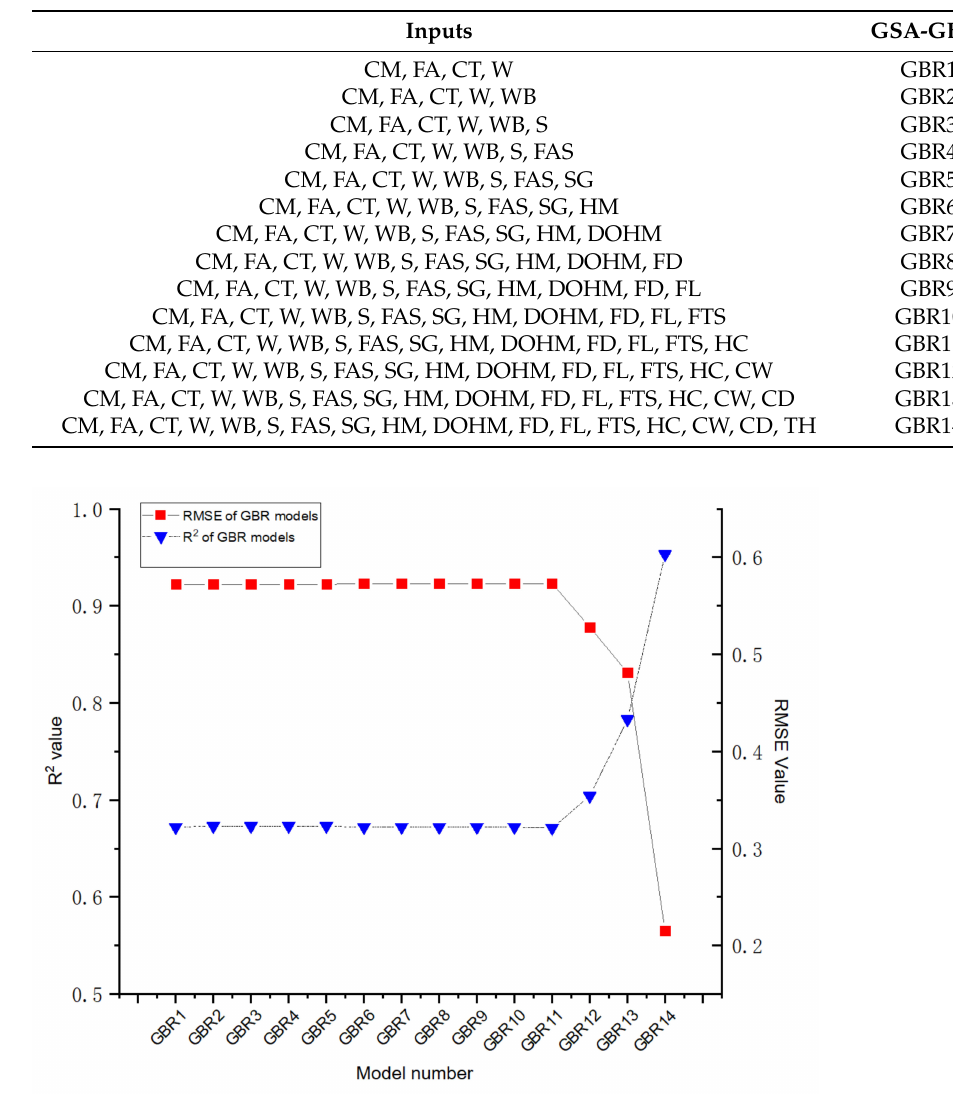
Table 6. Fourteen types of GSA-GBR models with various numbers of inputs.